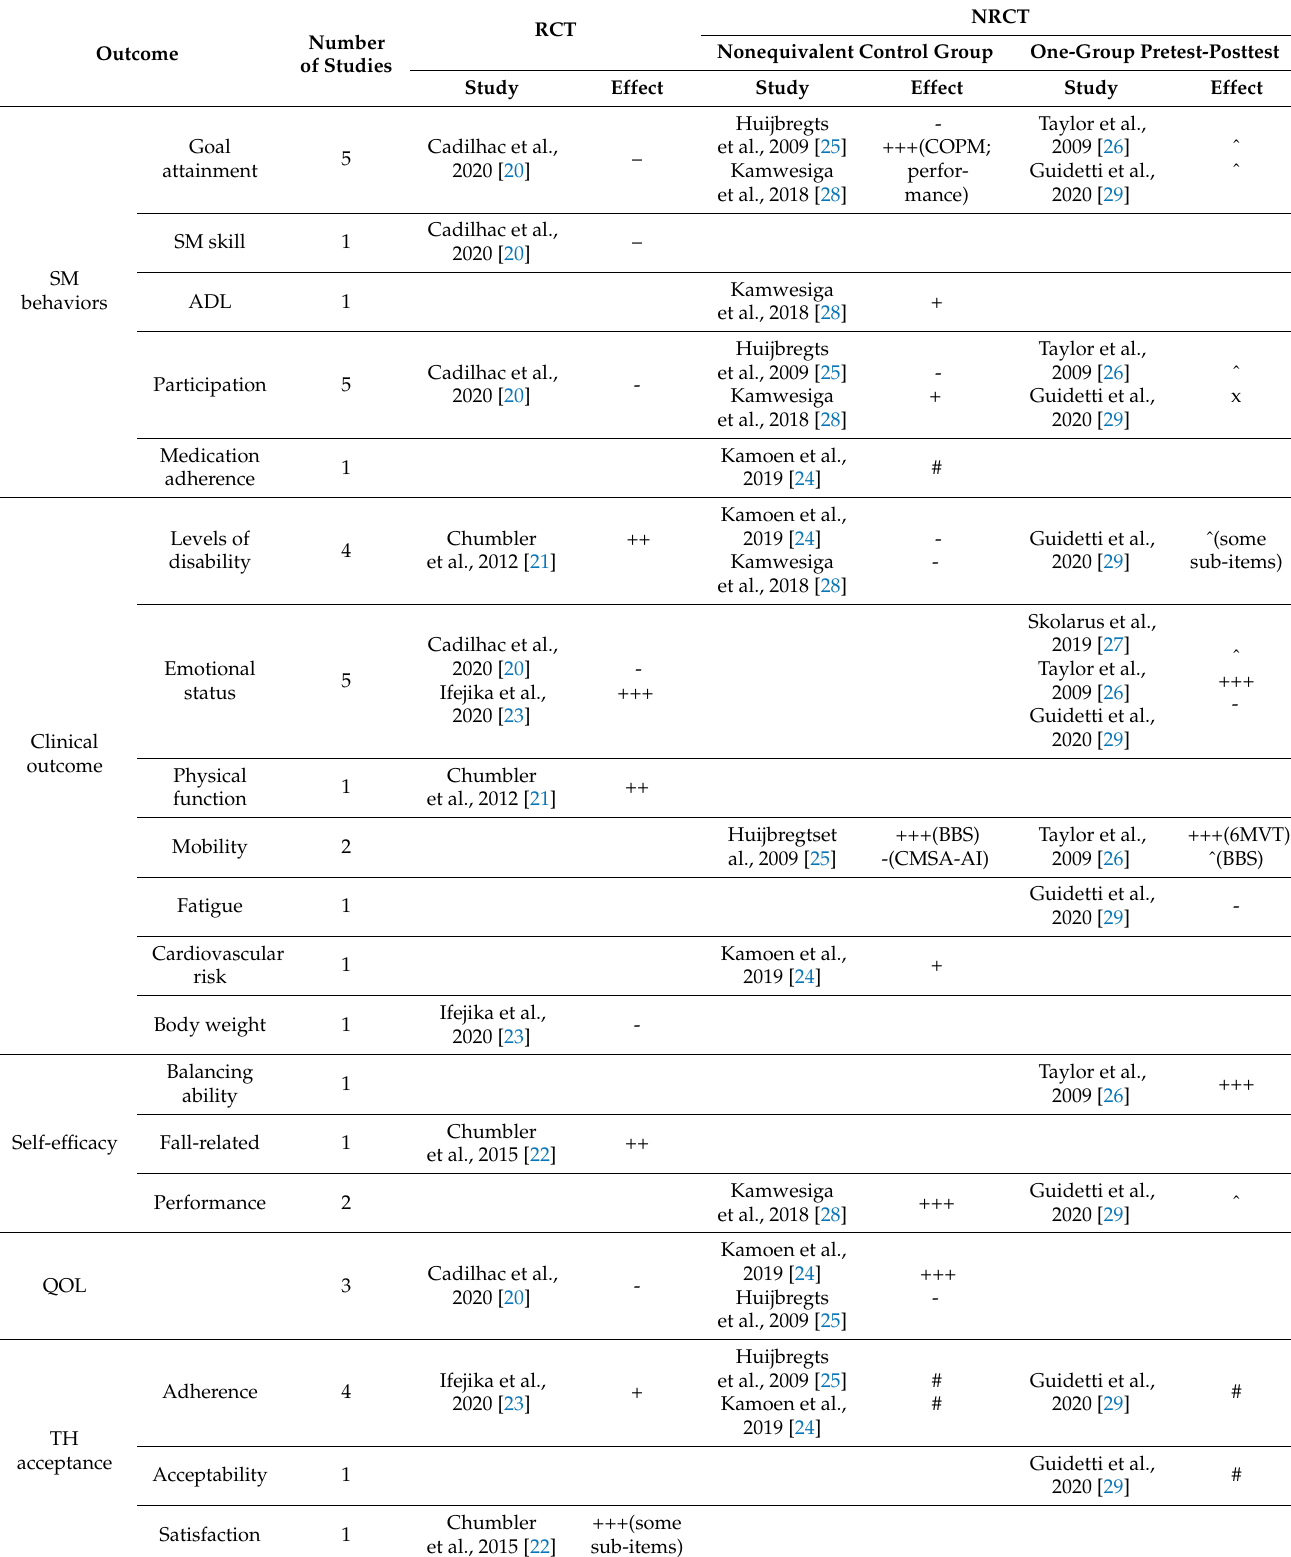
Table 6. Effects of TH-SM support